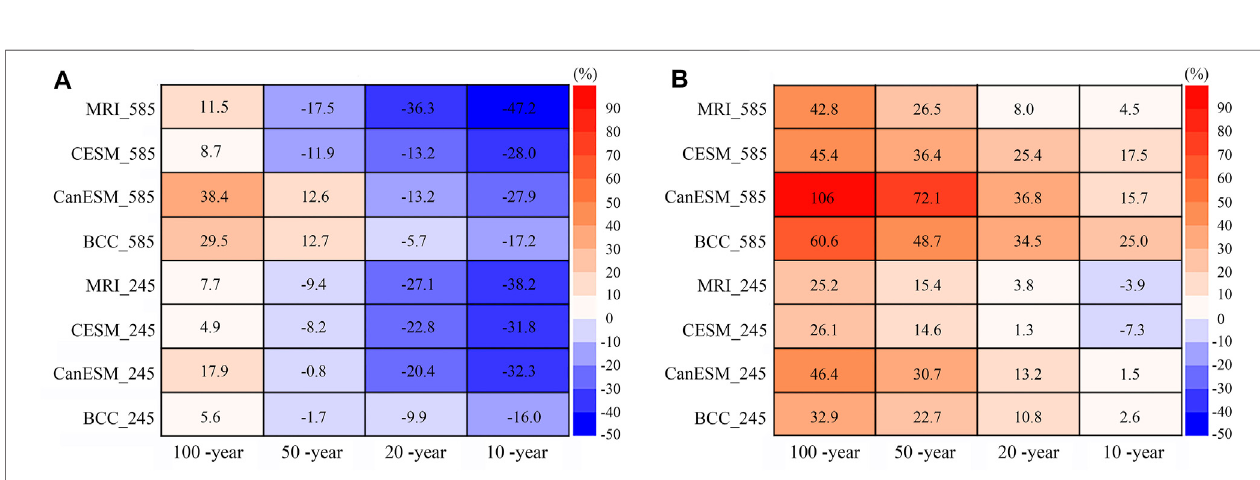
FIGURE 10 | Relative changes of design fl oods with 100-year, 50-year, 20-year, and 10-year return periods during two future periods 2050s (A) and 2080s (B) to the baseline period.